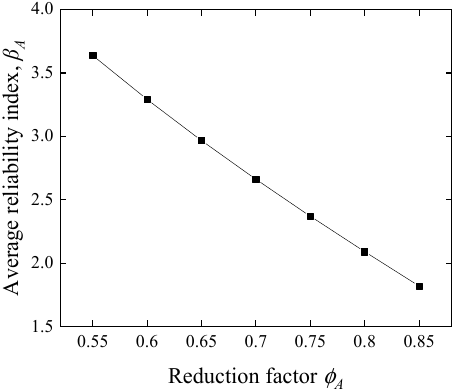
Figure 15. Effect of the reduction factor on the average reliability index.